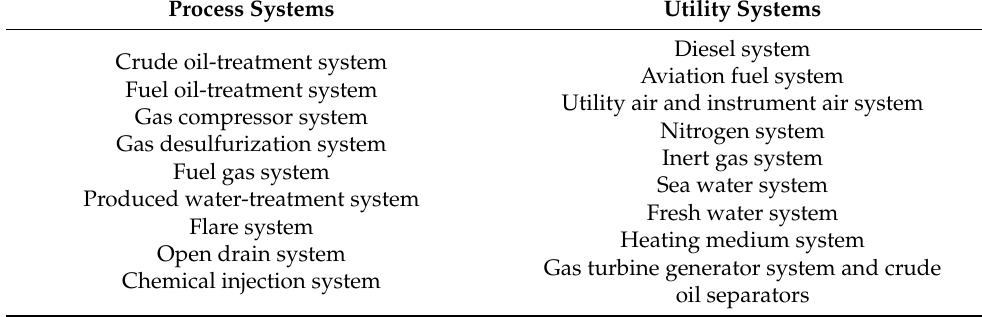
Table 1. Process and utility systems of LH11-1 FPSO.